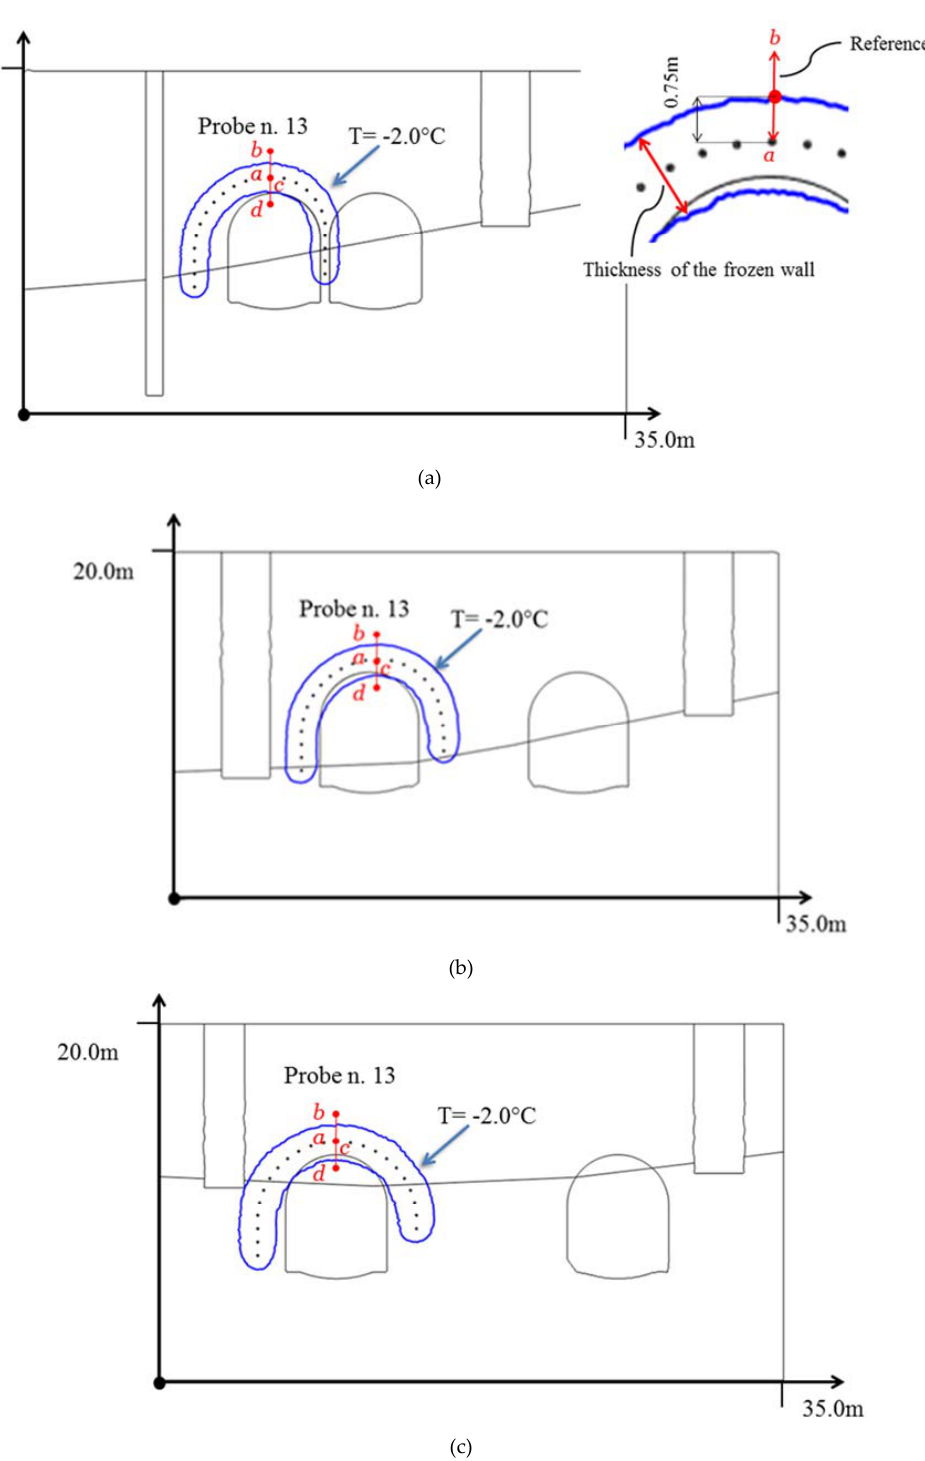
Figure 12. Thickness of the frozen wall represented through isotherm at –2 °C, for section A ‐ A (a), section B ‐ B (b); section C ‐ C (c).